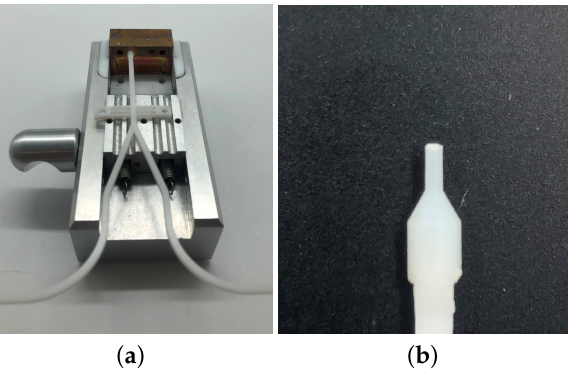
Figure 25. Setup for shaping the DWG end. ( a ) Mold to shape the end of the dielectric waveguide. ( b ) Dielectric waveguide with end fused in shape.